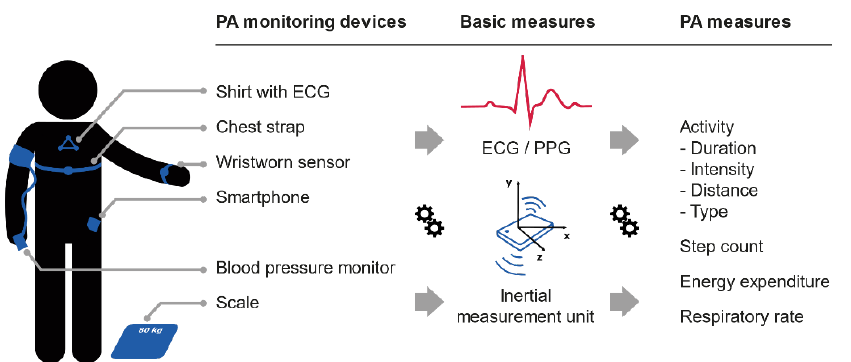
Figure 2. Mobile PA monitoring devices, basic measures, and derived physical activity (PA) measure. ECG, electrocardiogram; PPG, photoplethysmography.